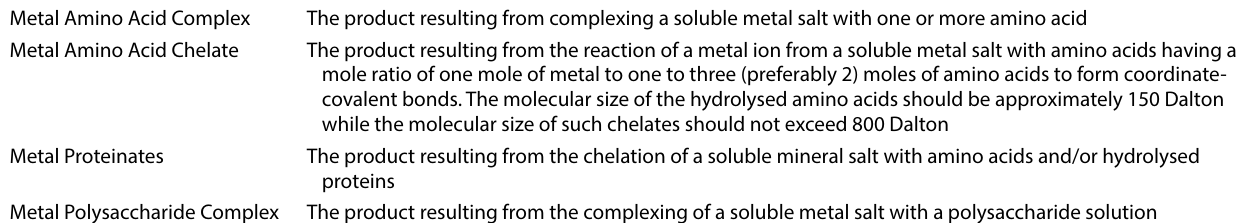
Table 1 AAFCO Organic trace mineral definitions Metal Amino Acid Complex Metal Amino Acid